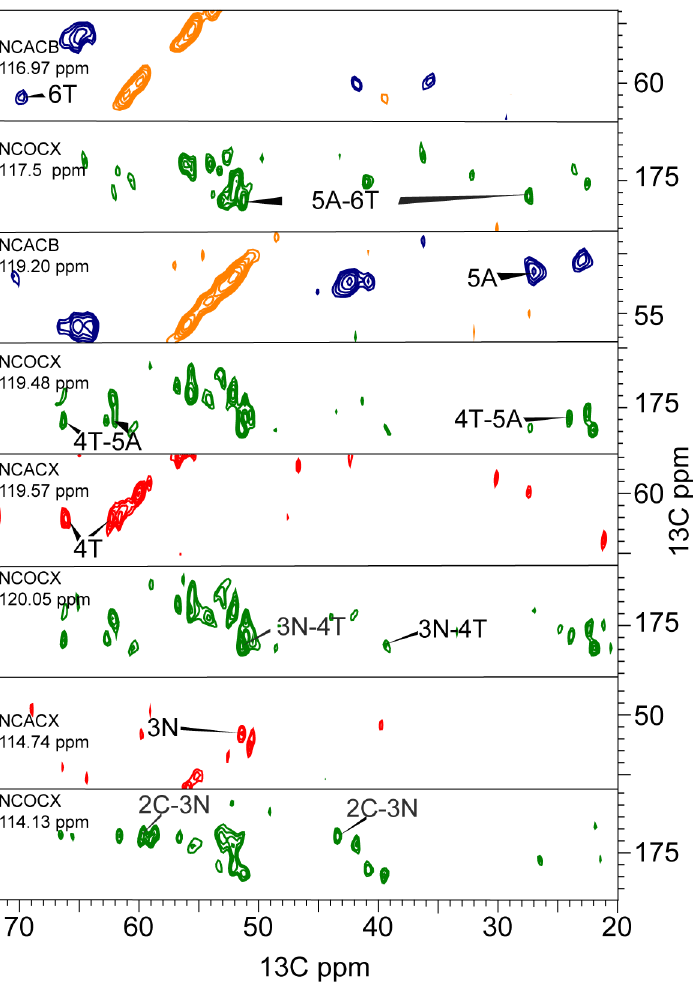
Fig 3. Sequential walk in the N-terminus via backbone nitrogen chemical shifts. The orange and blue peaks belong to a 3D NCACB spectrum (positive, negative) acquired at 14 kHz MAS at 14.1 Tesla. Red peaks belong to a NCACX 3D spectrum recorded at 14.1 Tesla and 11 kHz MAS spinning. Green peaks come from a 3D NCOCX experiment acquired at the same spectrometer at 14 kHz MAS spinning. All experiments were performed at a nominal sample temperature of 10°C. Reading from up to down, a spin system i is assigned to its backbone nitrogen shift in the upper strip. In the strip underneath, the preceding residue (green peaks) i-1 appears at the same nitrogen shift as found above. Deviations of up to 0.7 ppm appear due to the line-widths of the nitrogen chemical